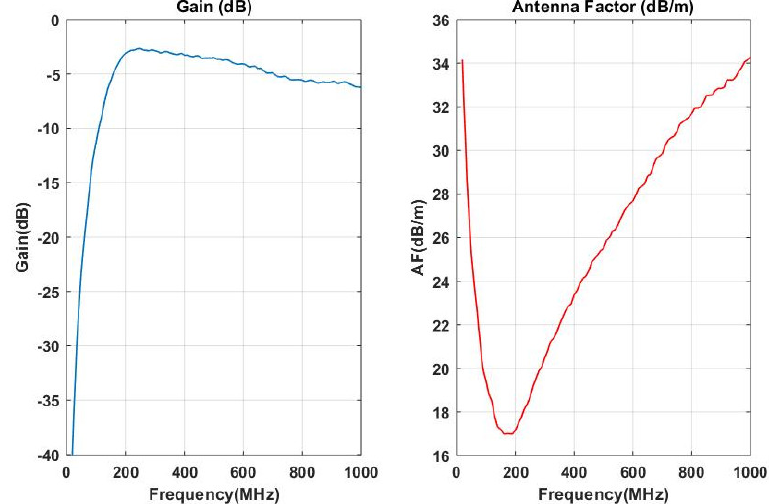
Figure 5 . Antenna gain versus frequency and antenna factor plot.